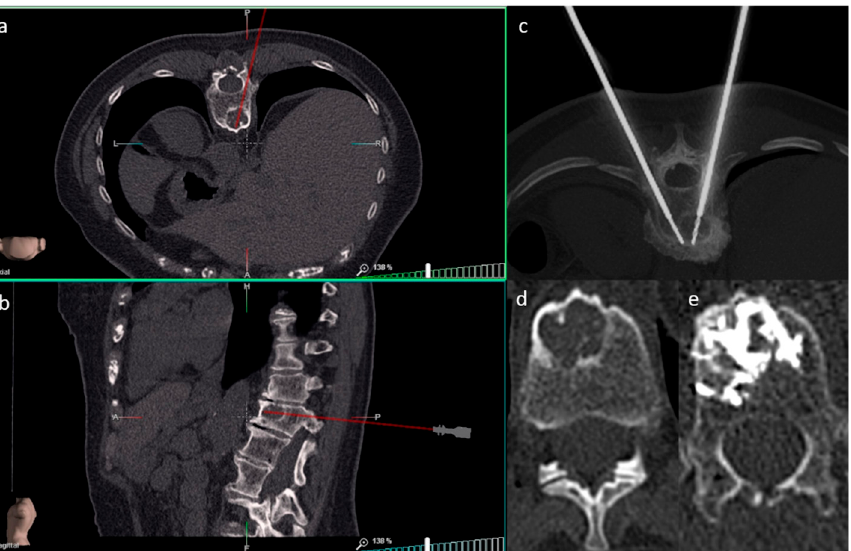
Figure 3. SIRIO-assisted needle positioning within a breast cancer metastasis of a lumbar vertebral body in order to perform an ablation procedure followed by cementoplasty. Axial ( a ) and sagittal ( b ) reconstructions of the virtual 3D model show the needle trajectory to the lesion. The axial reconstruction in ( c ) confirms the correct positioning of the needles within the lesion. The axial reconstructions in ( d , e ) show the bone lesion before ( d ) and after ( e ) the procedure with optimal final distribution of cement within the lesion ( e ).